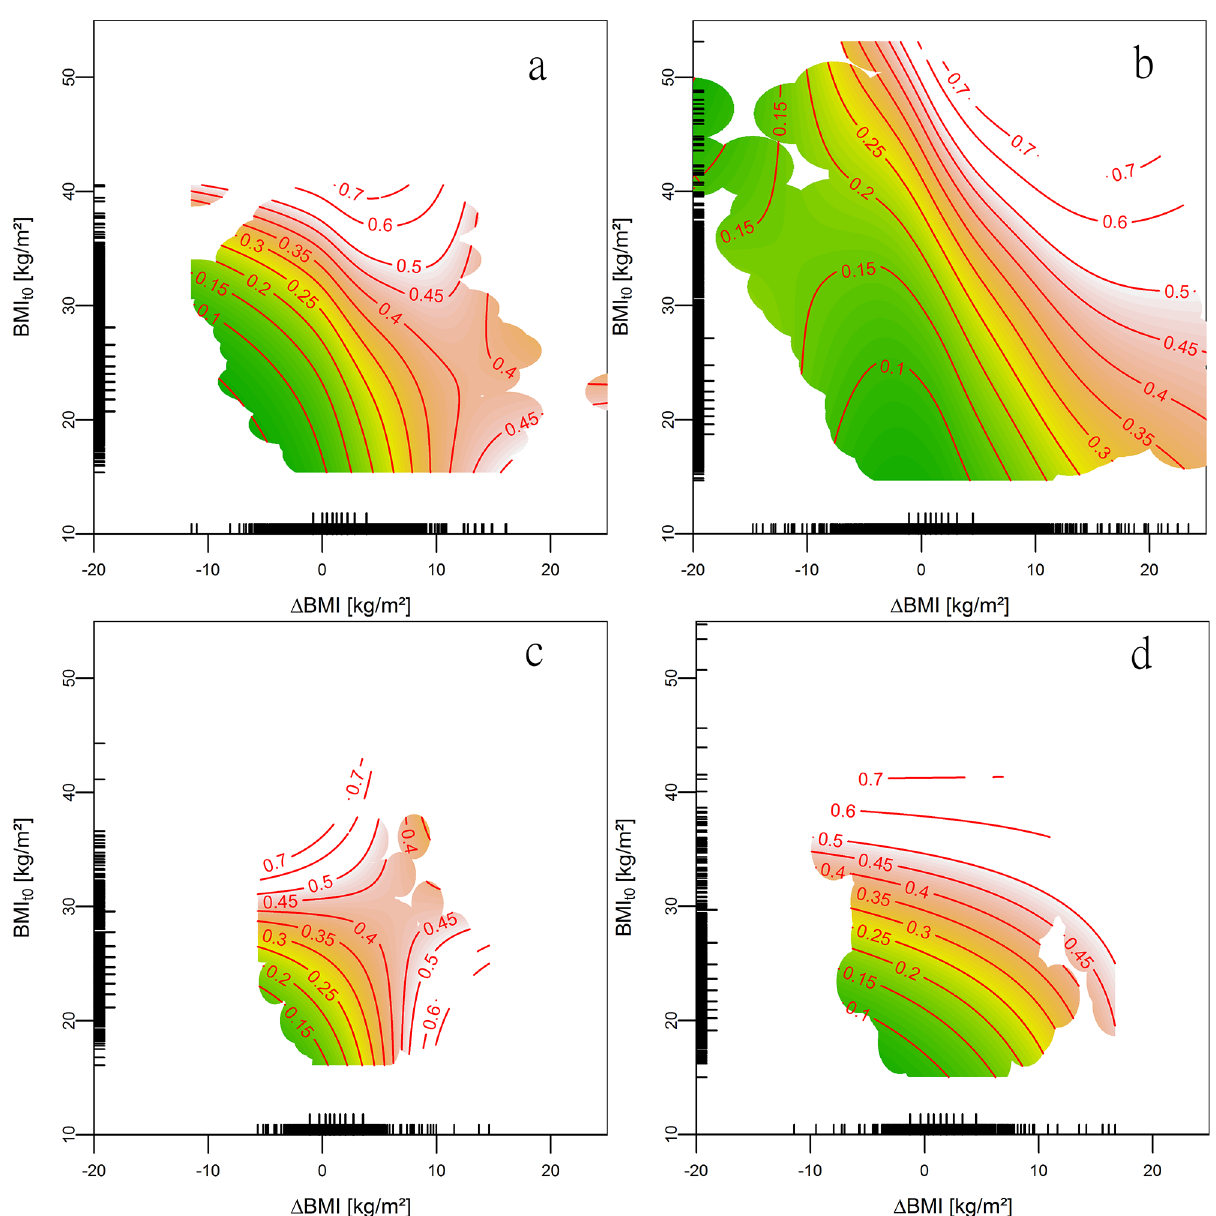
Fig 2. IFG risk by baseline BMI and BMI change estimated using generalized additive models. Absolute risk for development (a: men, b: women) and persistence (c: men, d: women) of impaired fasting glucose (IFG) by baseline BMI (y-axis) and Δ BMI (x-axis) for 30 year old individuals. Green indicates a low, yellow intermediate and red high risk. Contour lines (red lines) represent combinations of baseline BMI and BMI change being associated with the same risk. For example when looking at Fig 2a, at the “ 0.15 ” contour line (representing a 15% risk): There are men with a low baseline BMI and small BMI increase, and there are men with a high baseline BMI and pronounced weight decrease. Those men are at the same risk for development of IFG. Rather horizontal contour lines indicate baseline BMI is more strongly associated with IFG risk, rather vertical contour lines indicate BMI change is more strongly associated with IFG